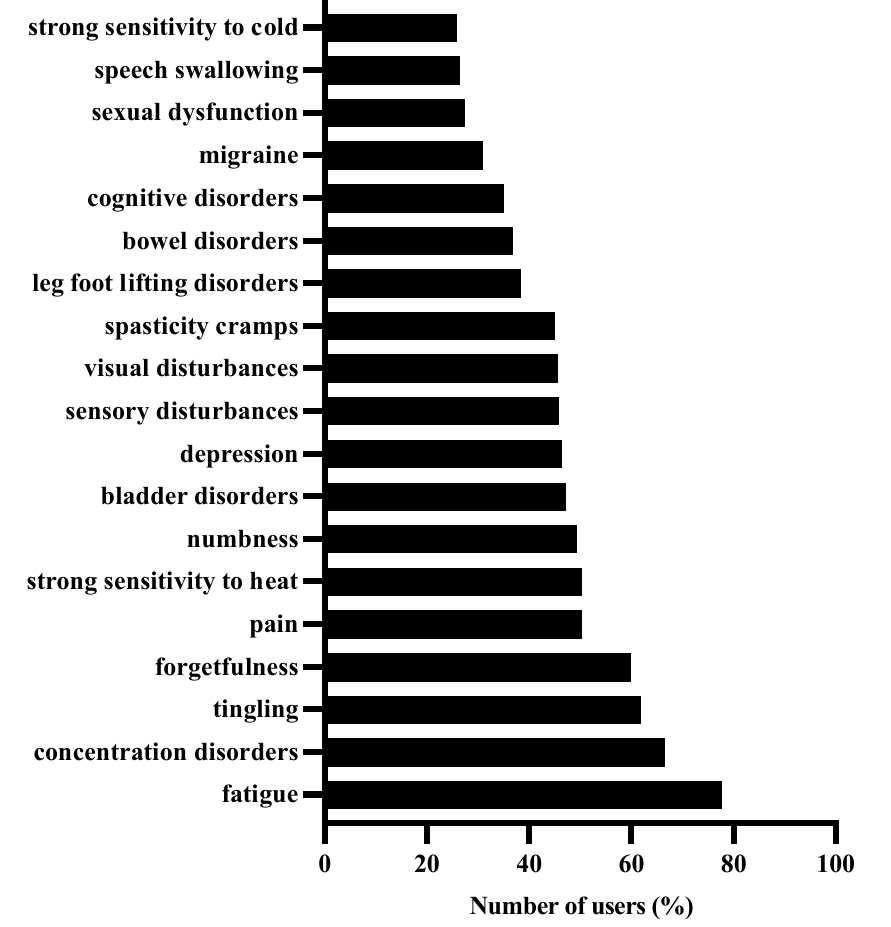
Figure 3. Symptoms of concern for users. The bar graph above shows the percentage of users who have tracked each symptom at least once after onboarding. Each user could track more than one symptom at a time.